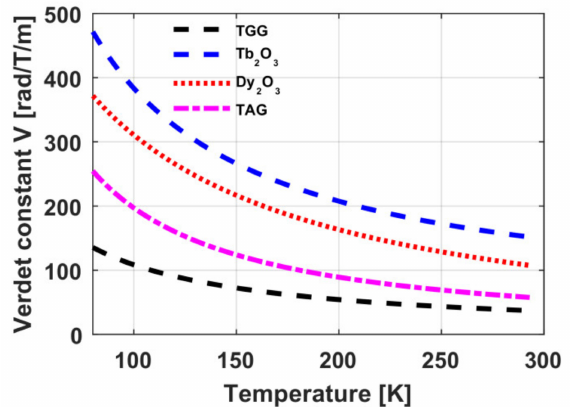
Figure 7. Verdet constant as a function of temperature at wavelength of 1064 nm: TGG [18,23], TAG [51], Tb 2 O 3 [53], Dy 2 O 3